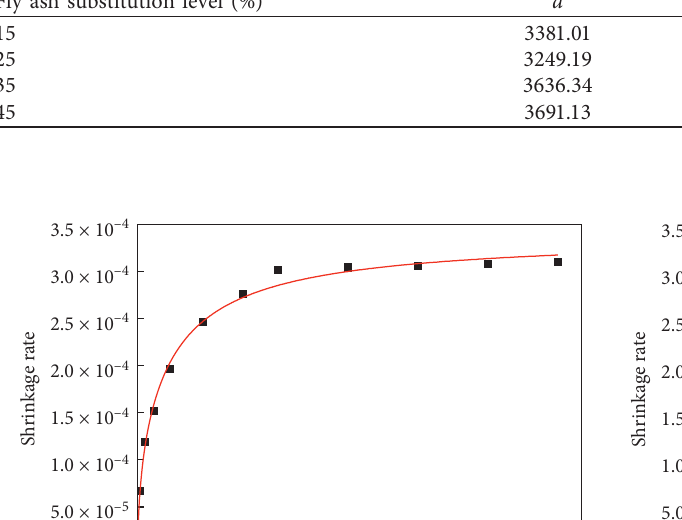
Table 4: Estimated parameters ( a and b ) for the modified theoretical shrinkage model and the resultant coefficient of determination ( R 2 ). Fly ash substitution level (%) a b R